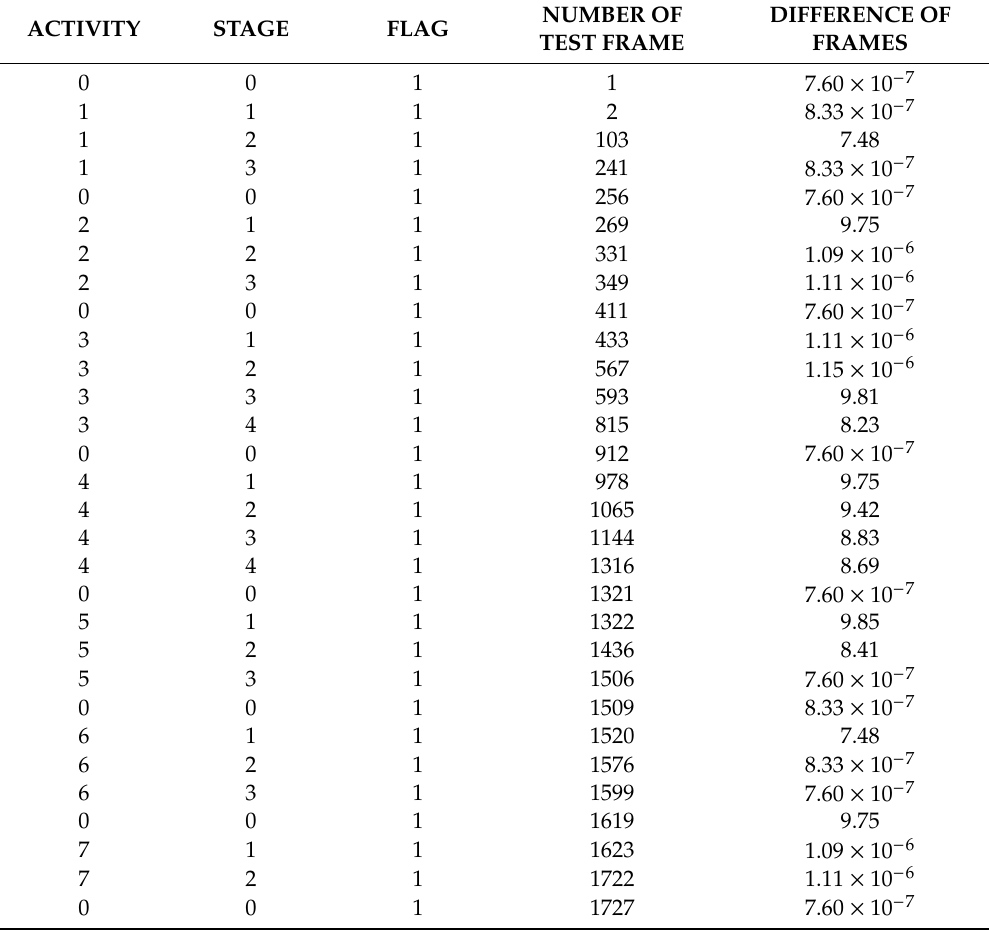
Table 3. Results of Algorithms 4 and